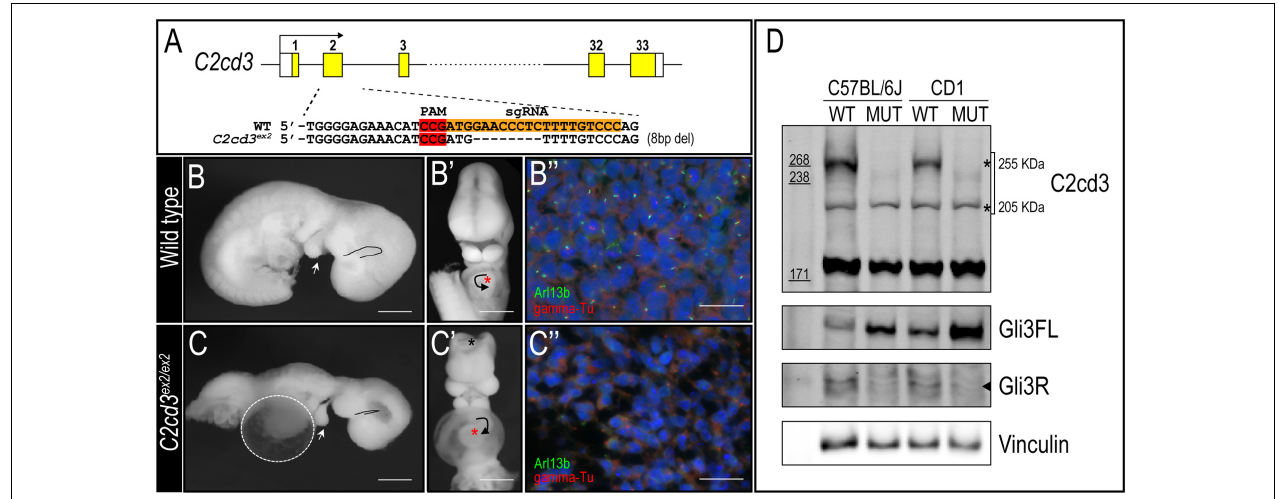
FIGURE 2 | C2cd3 ex2 / ex2 mutants present with phenotypes indicative of a ciliopathy. (A) Schematic of CRISPR-targeted 8 bp deletion in C2cd3 at exon 2 which results in a premature stop codon. (B,C) Lateral and (B (cid:48) ,C (cid:48) ) frontal views of E9.5 wild-type and C2cd3 ex2 / ex2 embryos. C2cd3 ex2 / ex2 embryos exhibit pericardial edema (white dashed line), tight mesencephalic flexure (black line), mandibular hypoplasia (white arrowhead), abnormal heart looping (black arrow), and exencephaly (black asterisk). The heart is labeled with red asterisks. (B (cid:48)(cid:48) ,C (cid:48)(cid:48) ) Axonemal (Arl13b) and basal body (gamma-tubulin) immunostaining of E9.5 embryos in wild-type and C2cd3 ex2 / ex2 embryos. Scale bars for panels (B–C (cid:48) ) : 0.5 mm; (B (cid:48)(cid:48) –C (cid:48)(cid:48) ) : 50 µ m. (D) Western blot of E9.5 wild-type and C2cd3 ex2 / ex2 whole embryos showing deletion of the 255 kDa isoform in both C57BL/6J and CD1 backgrounds. The ratio of Gli3FL/Gli3R is increased in C2cd3 ex2 / ex2 compared to wild-type.